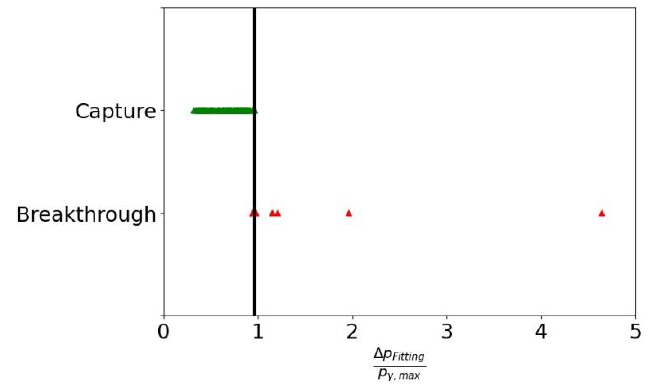
Figure 20. Droplet deformation versus the normalized pressure.